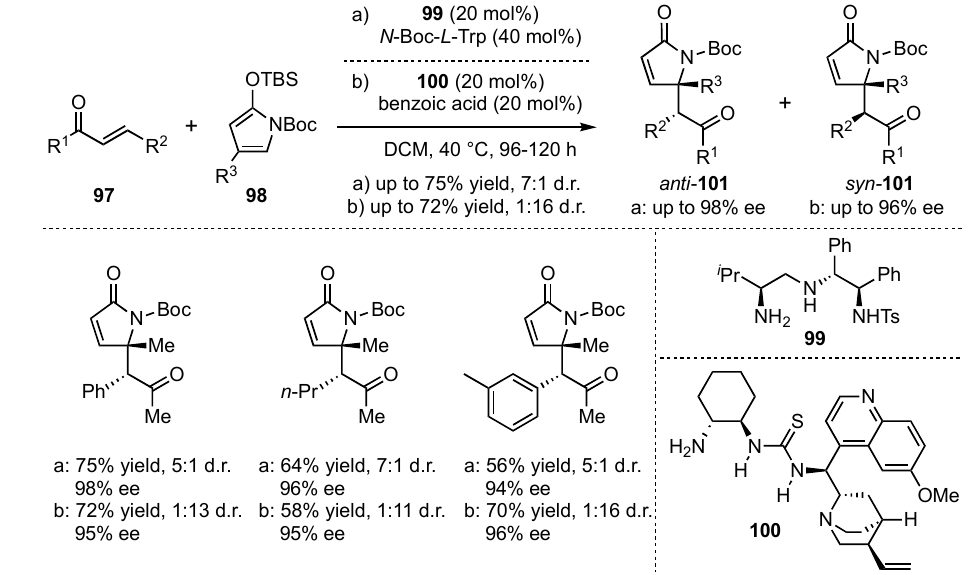
Molecules 2021 , 26 , x FOR PEER REVIEW Scheme 24. Diastereodivergent method for chiral amine organocatalyzed VMMcR with N -Boc- silyloxy-pyrrole-substrates by Ye and Dixon [66].